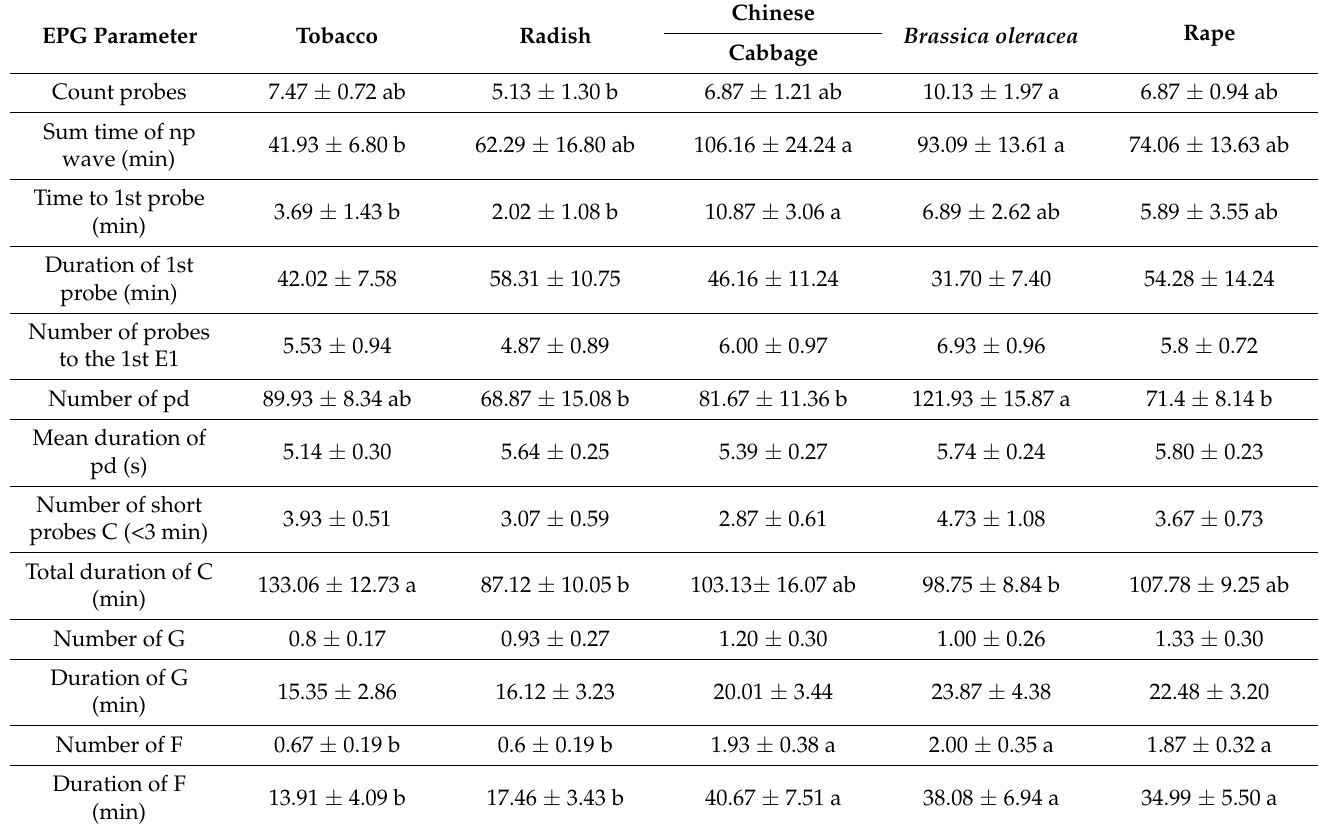
Table 1. EPG parameters of M. persicae feeding on the nonpenetration phase of five host